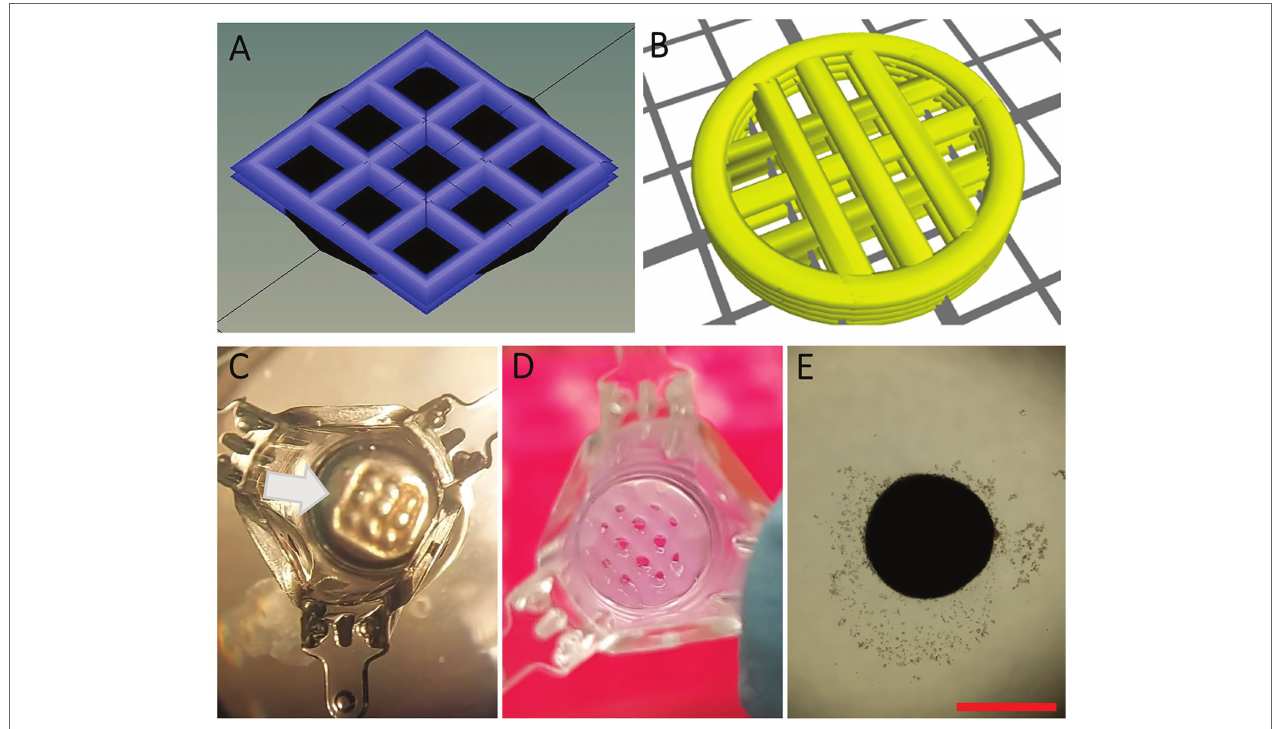
FIGURE 1 | Design and preparation of scaffolds. (A-B) 3D design of square-shaped one-layer scaffolds (1LSs, A ) and circular two-layer scaffolds (2LSs, B ). (C) To ensure proper cell seeding inside its macropores, 1LSs were transferred inside agarose sockets (white arrow) in culture inserts. (D) Because of their diameter